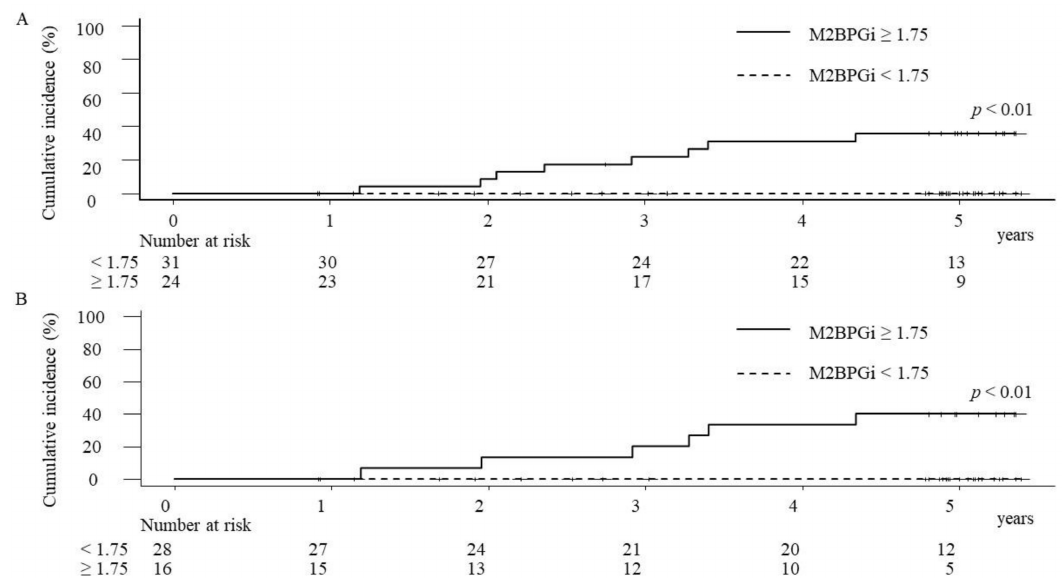
Figure 5. The cumulative hepatocellular carcinoma (HCC) incidence rates of overall cases ( A ) and SVR cases ( B ) after the start of the combination therapy with daclatasvir and asunaprevir. In both analyses of overall and SVR cases, the cumulative HCC incidence rates were significantly higher in the patients with the serum mac-2 binding protein glycosylation isomer (M2BPGi) ≥ 1.75 COI (cutoff index) than those with M2BPGi levels <1.75